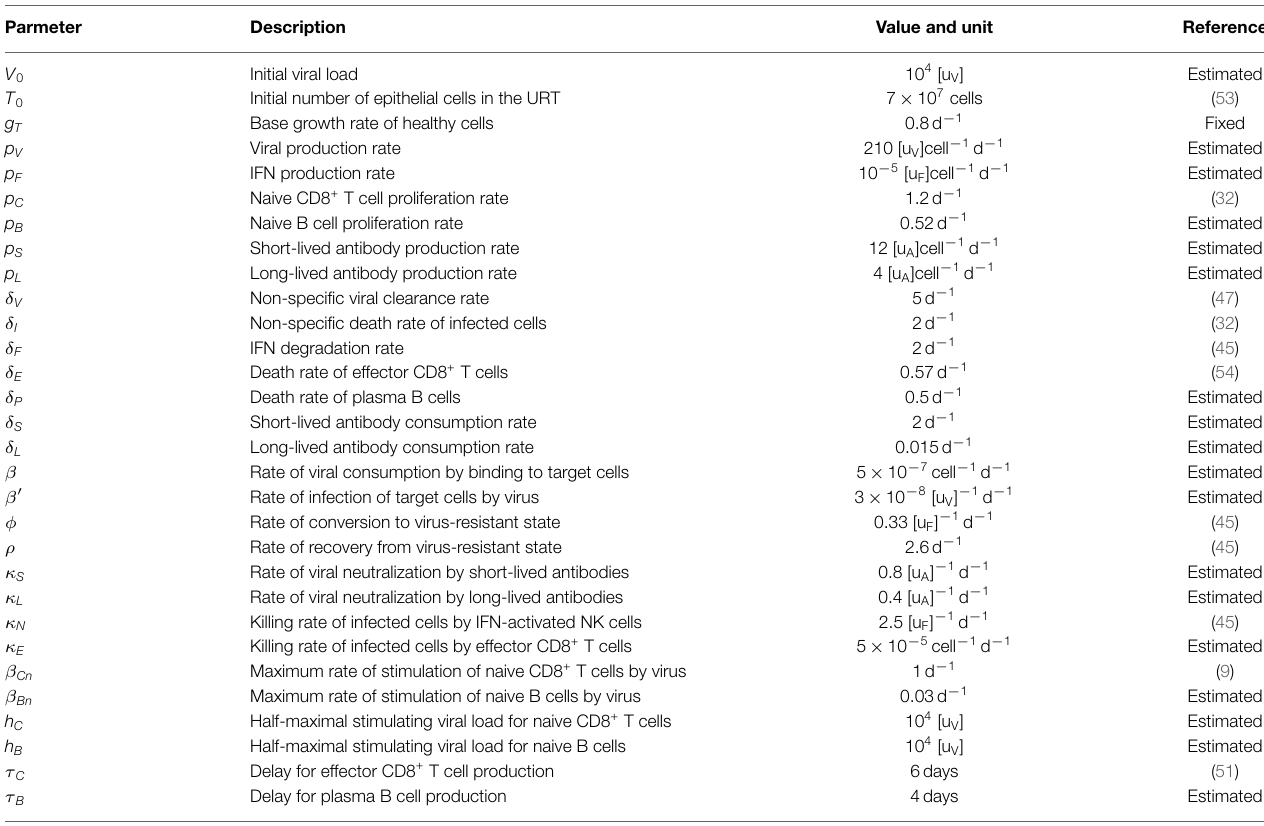
TABLE 1 | Model parameter values obtained by fitting the model to experimental data .